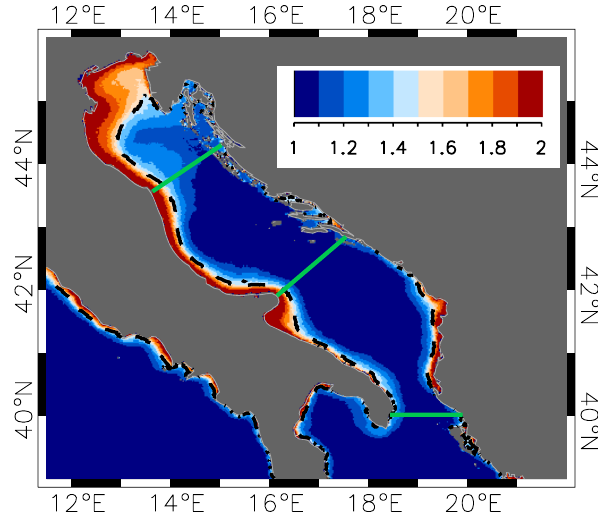
Fig. 1. Adriatic Sea domain of analysis. The color represents a multi-annual average of an optical index varying between 1 and 2 and quantifying a membership to optical classes 1 or 2 (see text for definition). The dashed black line is the 1.5 isoline separating the regions most often classified as Class 1 or 2. Green lines par- tition the Adriatic Sea into northern, central and southern regions (NADRS, CADRS, and SADRS,